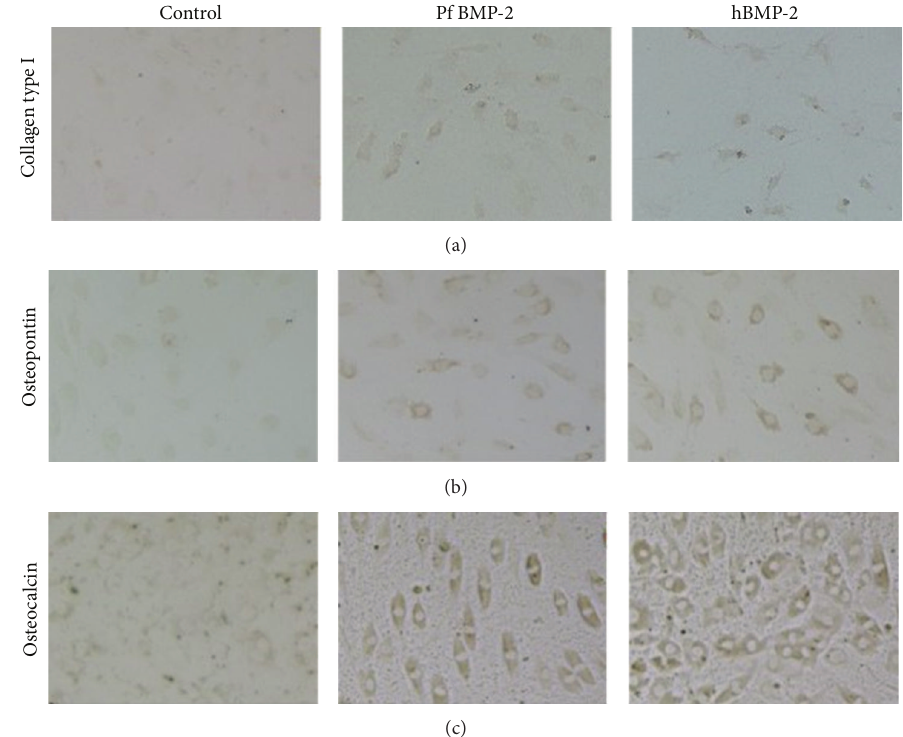
Figure 8: Immunohistochemical staining for osteogenic markers in C3H10T1/2 cells. C3H10T1/2 cells were plated into 40 mm culture dishes for 2 days and then treated with 250 ng/mL Pf BMP-2 synthetic polypeptide or 1 𝜇 g/mL synthetic polypeptide of the knuckle epitope of human BMP-2 (hBMP-2) for the indicated time periods. (a) Immunohistochemical staining of collagen type I after 7 days in culture. (b) Immunohistochemical staining of osteopontin after 13 days in culture. (c) Immunohistochemical staining of osteocalcin after 18 days in culture. Cells were photographed at 100x